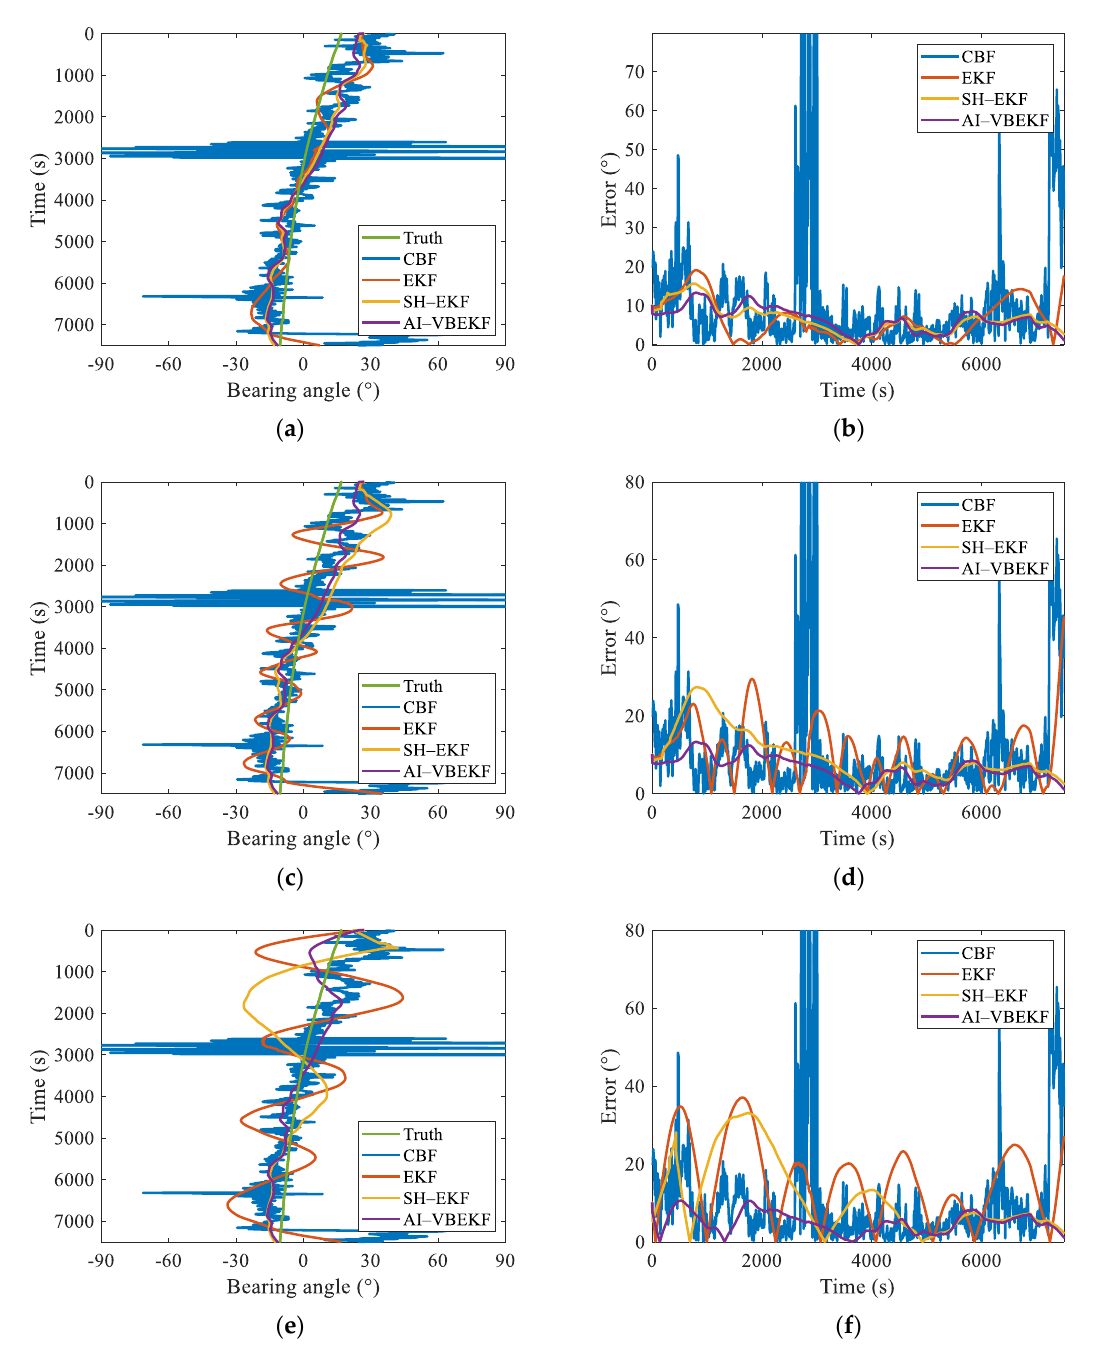
Figure 8. Experimental results of CBF-based DOA estimation, EKF, SH-EKF and AI-VBEKF on data with noise. ( a ) Trajectories obtained using the data with added noise under P 0 = diag 25,10 − 5 ] , ( b ) BEEs obtained using the data with added noise under P 0 = diag 25,10 − 5 ] , ( c ) trajectories obtained using the data with added noise under P 0 = diag 50,10 − 5 ] , ( d ) BEEs obtained using the data with added noise under P 0 = diag 50,10 − 5 ] , ( e ) trajectories obtained using the data with added noise under P 0 = diag 100,10 − 5 ] , and ( f ) BEEs obtained using the data with added noise under P 0 = diag 100,10 − 5 ] .